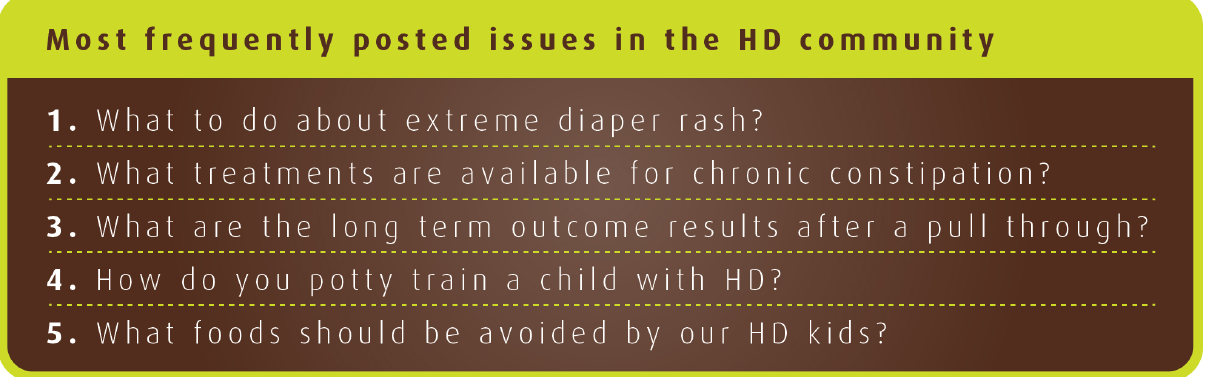
Figure 3. The five most common issues raised in HD community on the Facebook page.